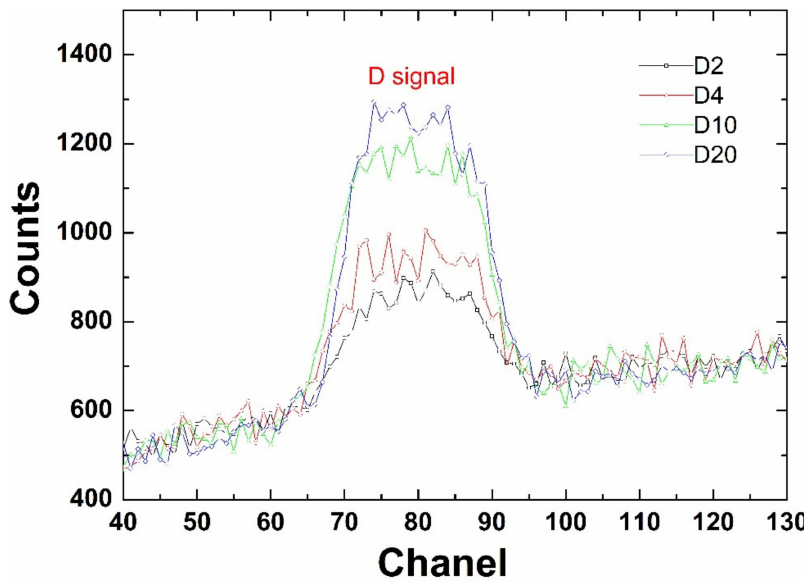
Figure 4. Deuterium signal extracted from the experimental RBS spectra measured for the Be-D layers deposited on graphite substrate.